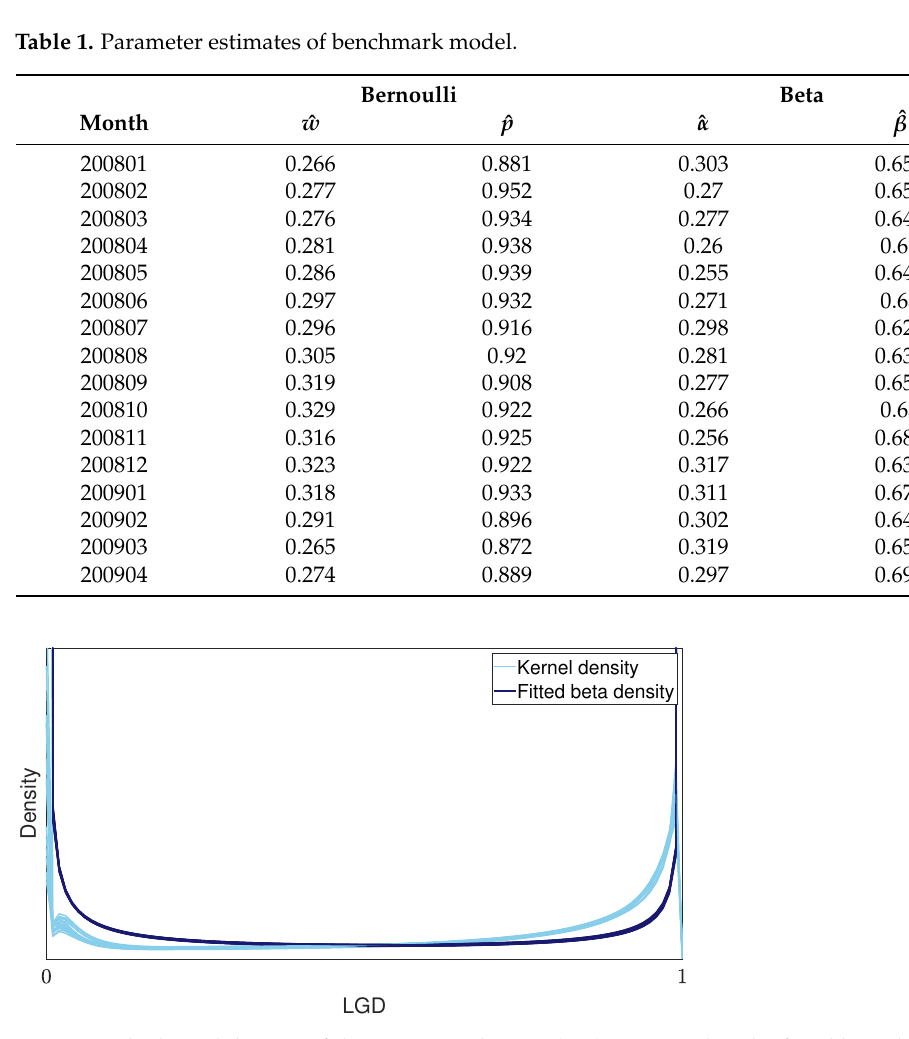
Figure 3. The kernel density of the raw LGD data on (0, 1) compared to the fitted beta density for each month from January 2008 to April 2009.